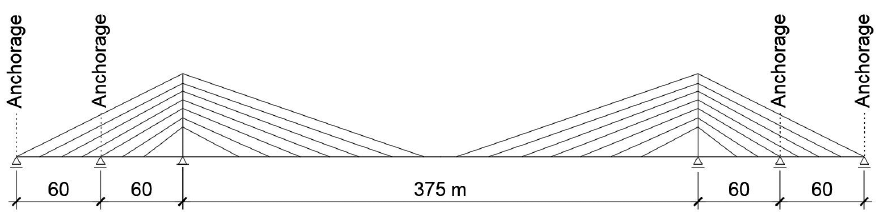
Figure 4. Static scheme of the cable-stayed part of the bridge with span sizes, units in